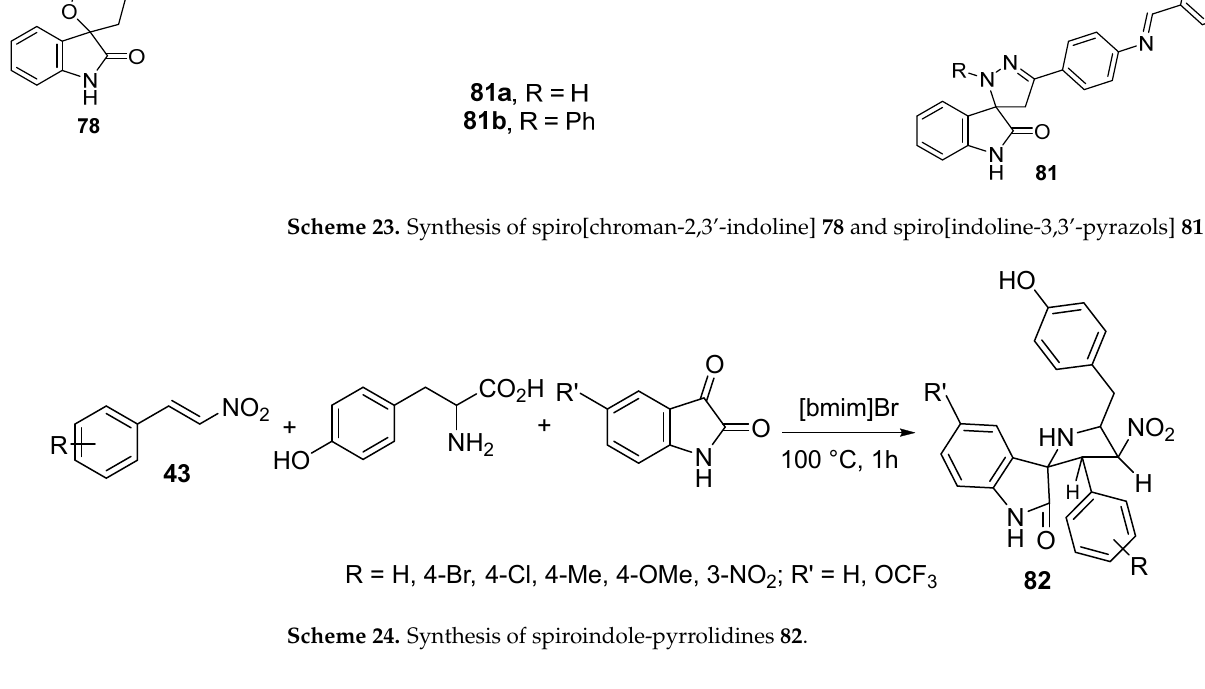
of tyrosine and isatins) cycloaddition with β -nitrostyrenes 43 afforded the spiroindole-